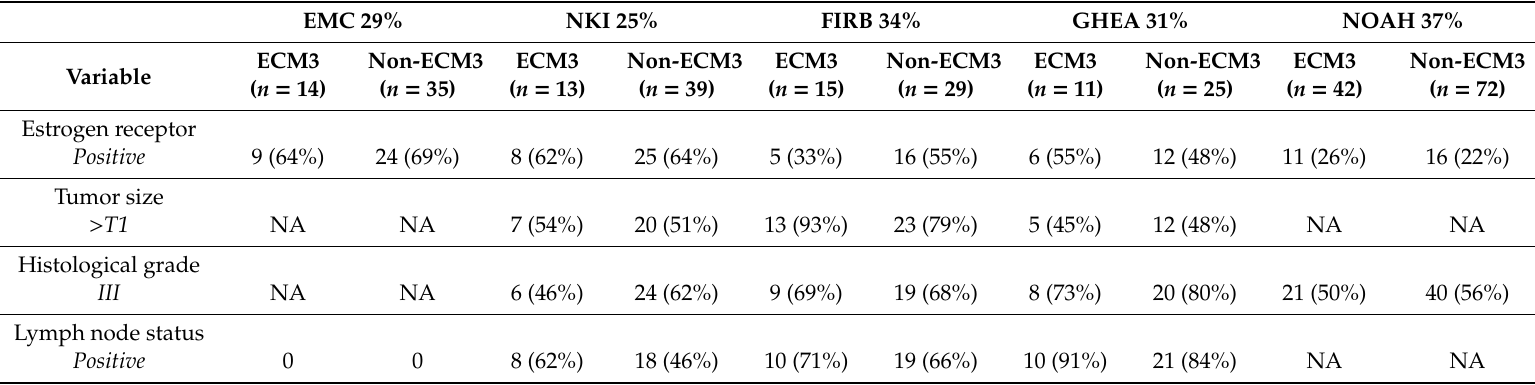
Table 1. Frequency of clinico-pathological characteristics of patients according to the extracellular matrix gene expression pattern